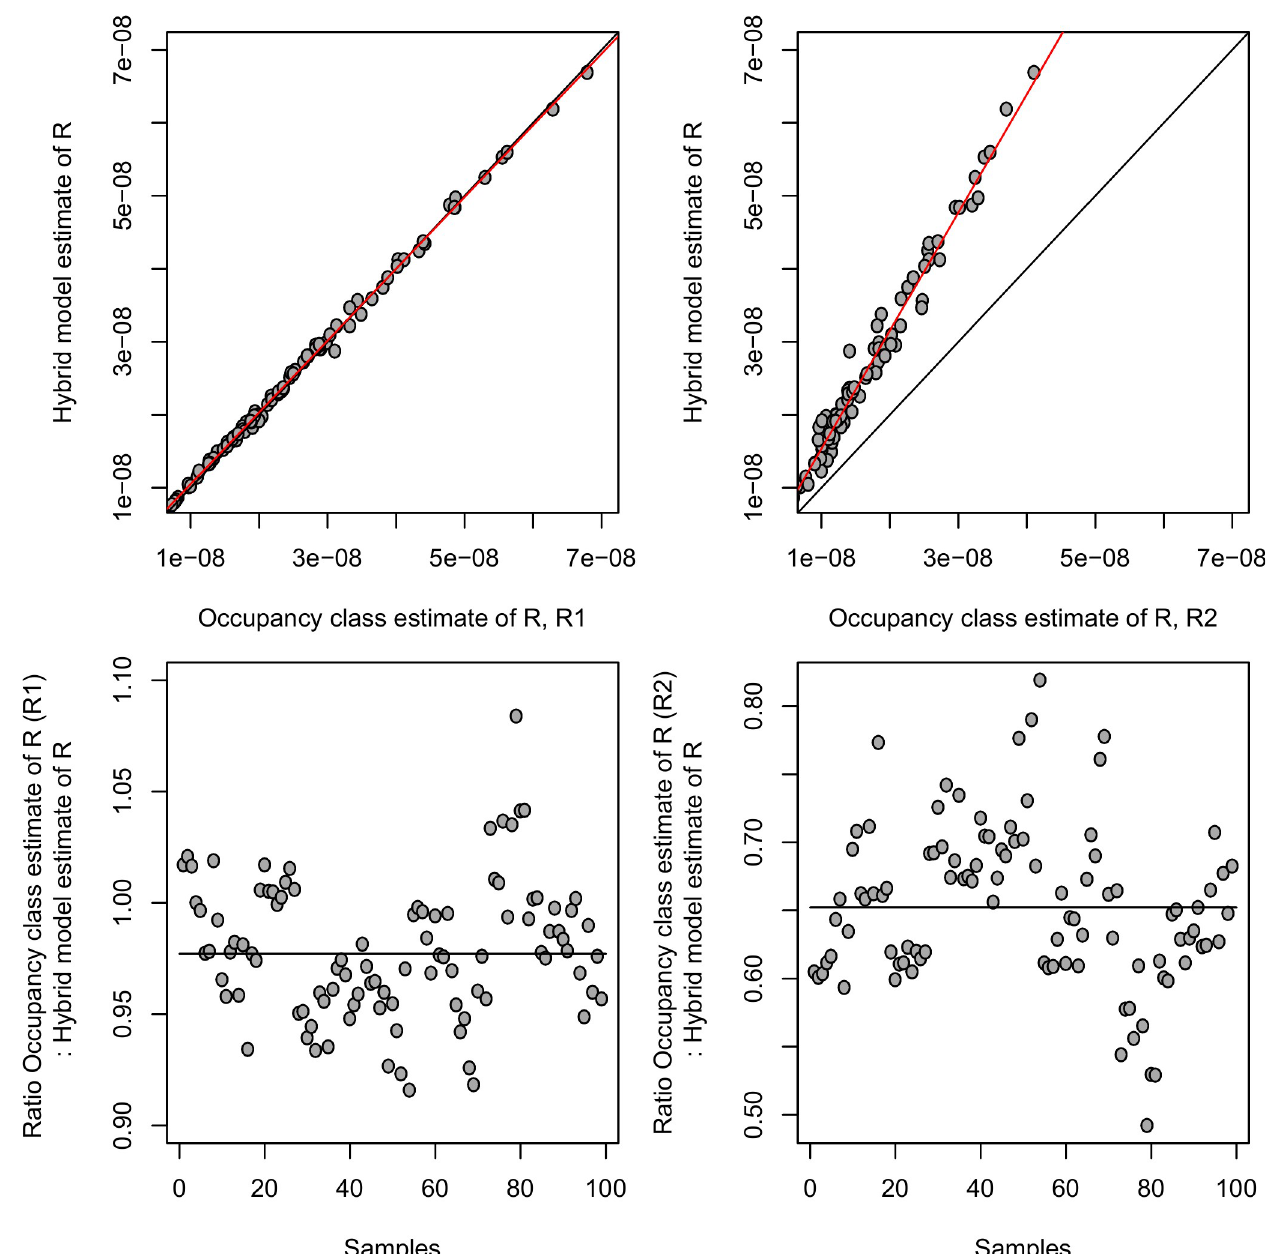
Fig 6. Comparison of estimates of ratio of infectious to mitotic spread from the hybrid model (method 1) and the occupancy class model (method 3). (Top left) Estimate of ratio from hybrid model plotted against first estimate from occupancy class model ( R equality. (Top right) Estimate of ratio from hybrid model plotted against second estimate from occupancy class model ( R 2 ). Red line is line of best fit, black line is line of equality. (Bottom left) Estimate of ratio between hybrid model and first estimate from occupancy class model ( R median. (Bottom right) Estimate of ratio between hybrid model and second estimate from occupancy class model ( R 2 ). Black line denotes the median.